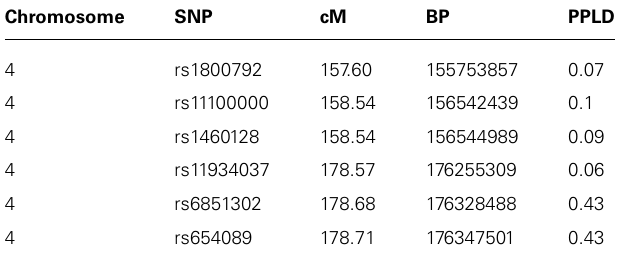
Table 1 | Chromosome 4 SNPs with PPLD ≥